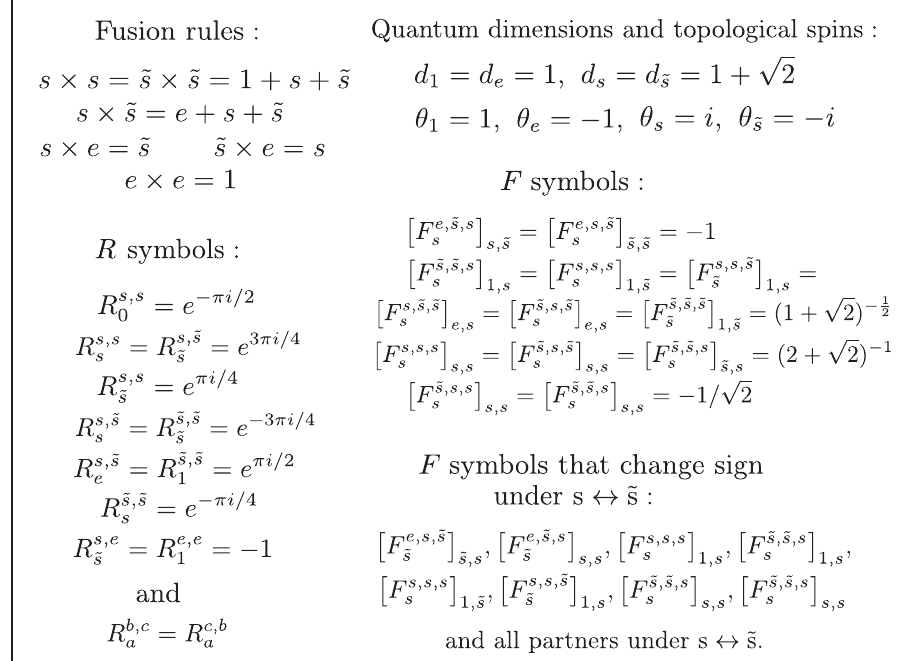
FIG. 1. Braiding statistics and fusion data for SO ð 3 Þ